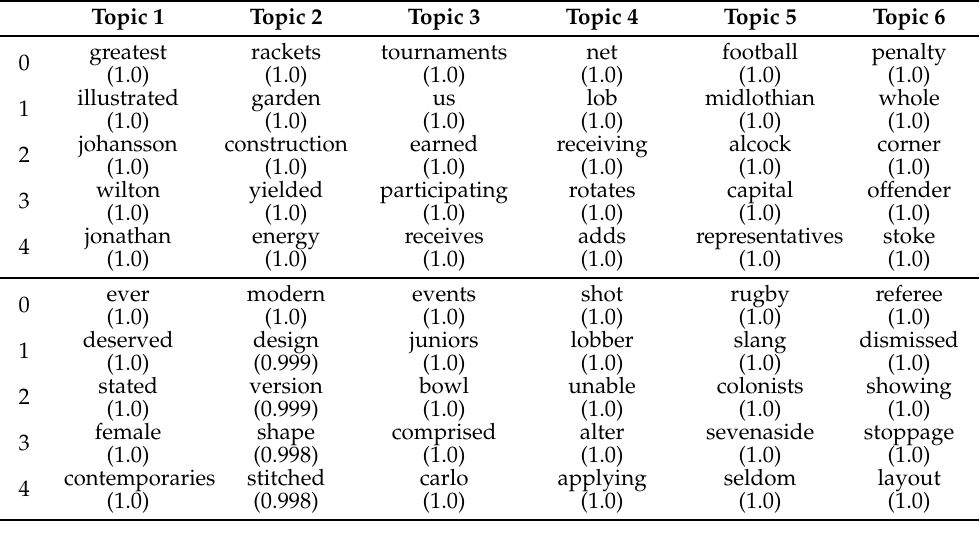
Table A11. For the most significant two words per topic, the four nearest neighbors based on cosine similarity are listed.